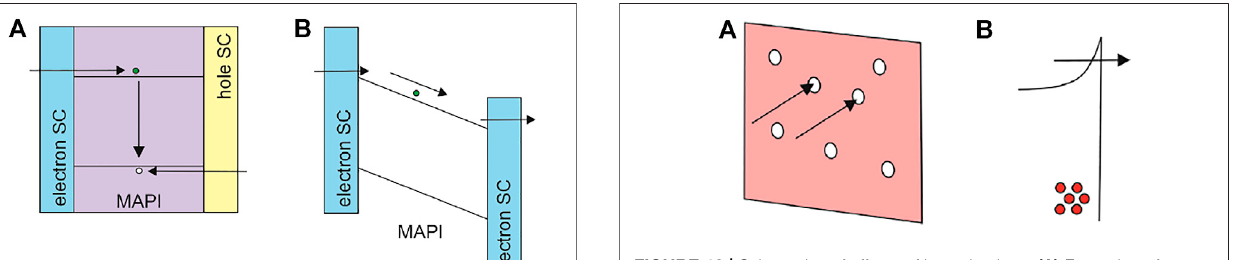
FIGURE 18 | Schematics of effects of incoming ions. (A) Formation of conductive sites by the local reaction. (B) Reduction of an electrostatic barrier by increased